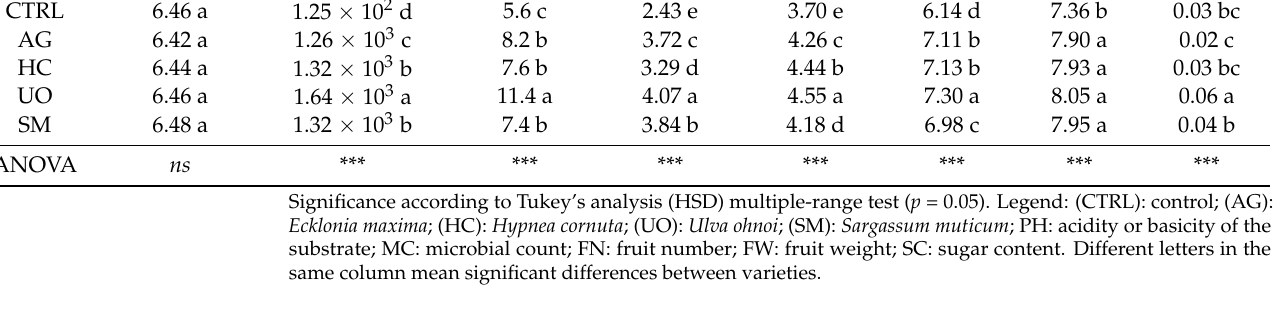
Table 4. Evaluation of microbial biomass, production, sugar, and vitamin content in Mammillaria